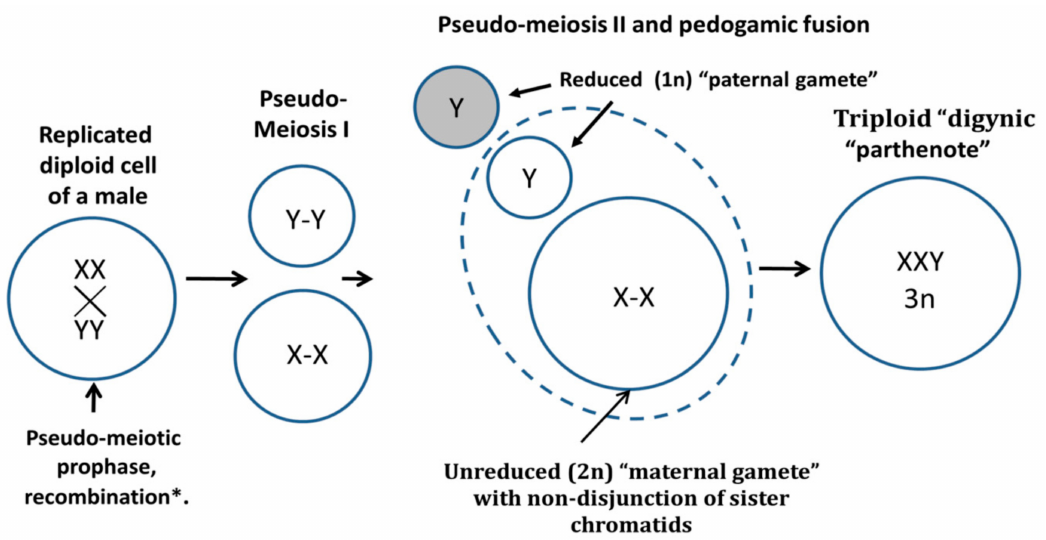
Figure 1. A conceptual schematic of the digyny-like formation of XXY triploid karyotypes in somatic male tumors revealed in the Mitelman karyotypes database data [10,11]. The reprogrammed male tumour cell triggers from G2-phase the aberrant molecular pathway of meiosis (here termed pseudo-meiosis), undergoes recombination between cohesed sisters and homologues *, pseudo-meiosis I segregating maternal, and paternal progenies with cohesed sister chromatids, reduction to haploidy of the “paternal gamete” in the pseudo-meiosis II and its pedogamic fusion with the unreduced diploid “maternal gamete” resulting in triploid “digynic parthenote”. * For recombination details, which are aberrant, see